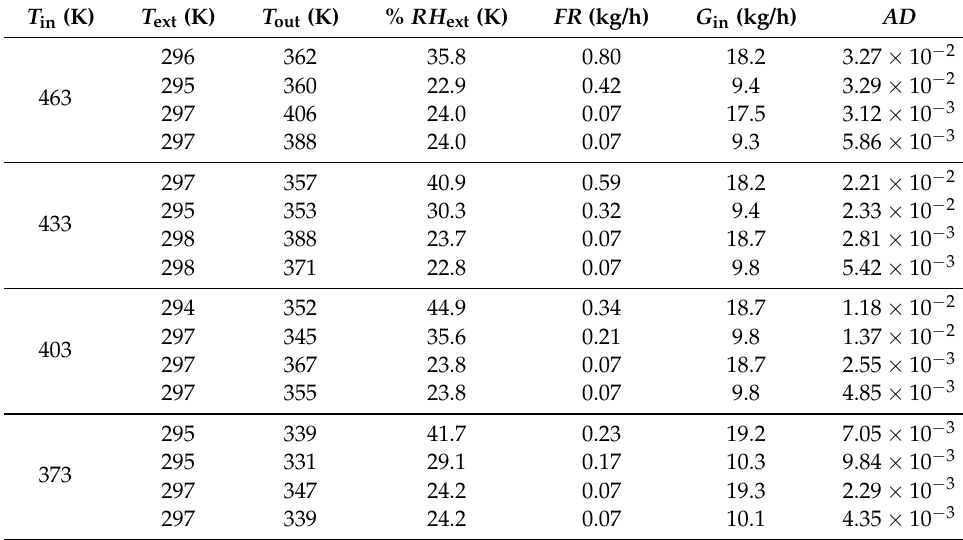
Table 2. Spray dryer’s processing limits obtained from atomizing water experiments. T in